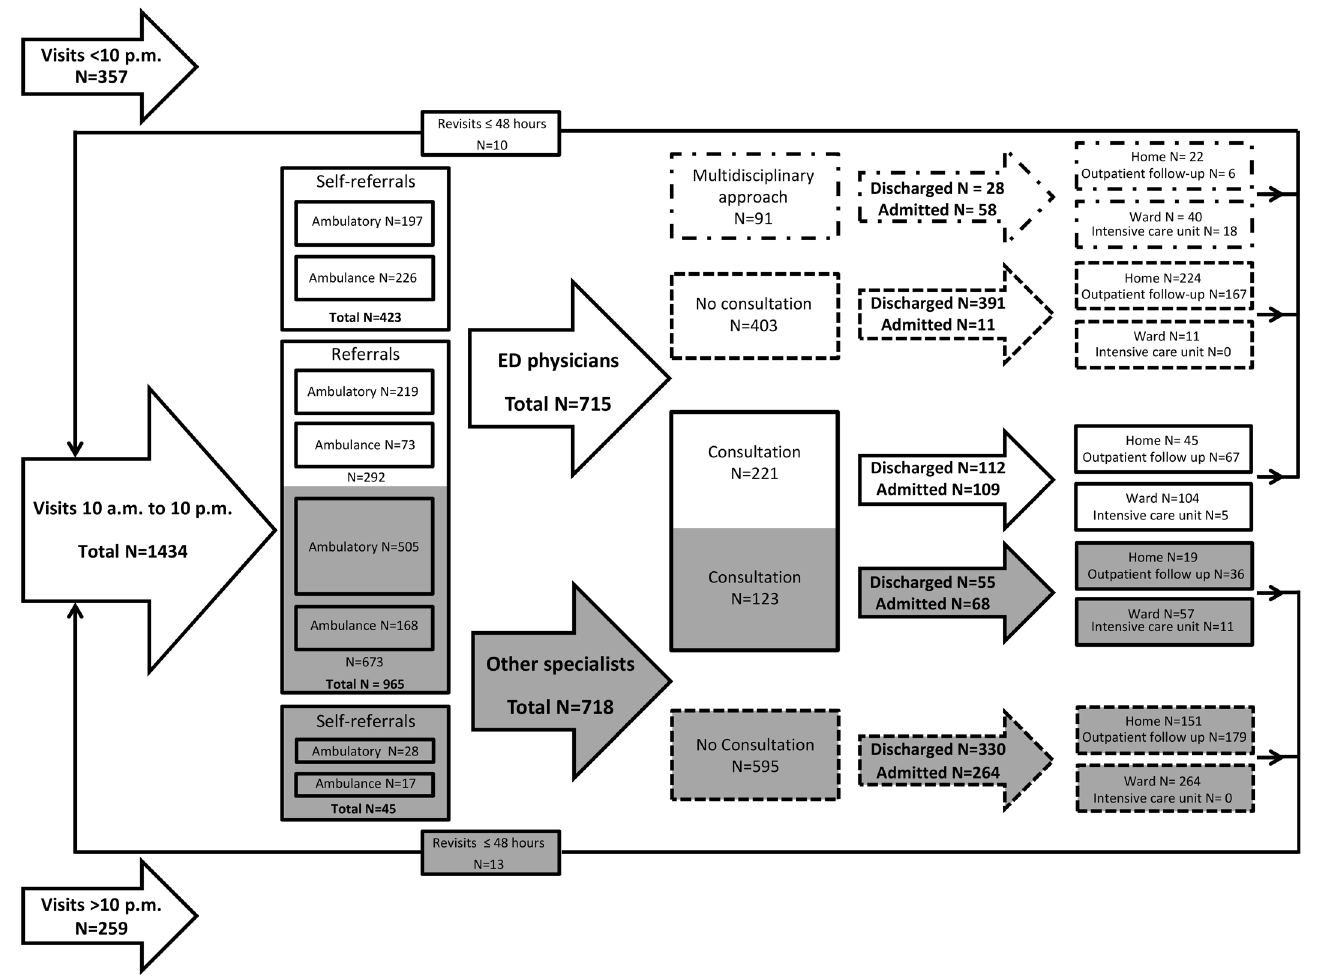
Fig 1. Input, throughput and output flow diagram of included patients. Patients treated by the ED physician are depicted in white, and those treated by the other specialties in grey. The boxes with dashed lines present patients that received no consultation or multidisciplinary approach. When the lines are closed, patients received one or multiple consultations. One patient was admitted to the ward without being treated by any physician. In 1 patients the final disposition was unknown. Six patients had another final disposition as depicted, of whom 5 had died on the ED and 1 returned to the psychiatric hospital were the patient was admitted before arrival at the